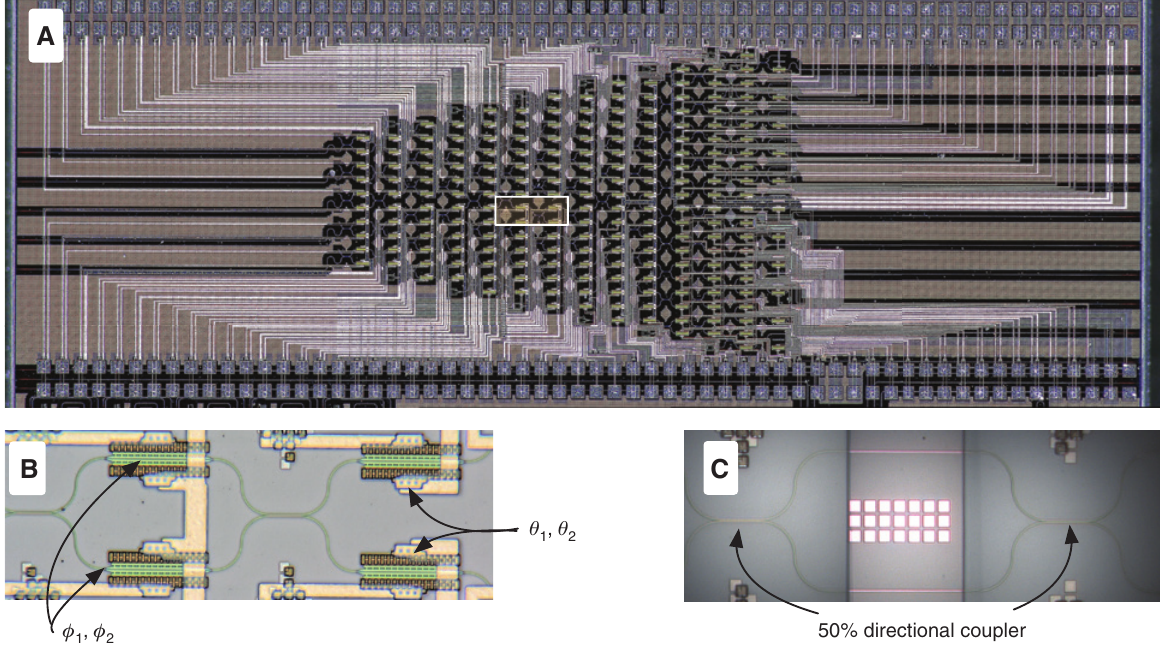
Figure 3: Optical micrographs of QPP fabricated in a silicon photonics platform. (A) The QPP measures 4.9 mm by 1.7 mm and is composed of 56 Mach-Zehnder interferometers, 213 phase shifters, and 112 directional couplers. The average RBS visibility was measured to be 0.9993 ± 0.0002. (B) Single RBS unit cell with two internal and two external low-loss phase shifters. (C) RBS unit cell test structure without phase shifters. Waveguides and directional couplers are